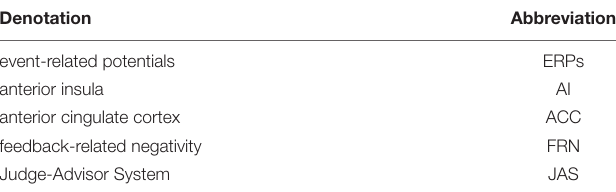
TABLE A1 | Symbol